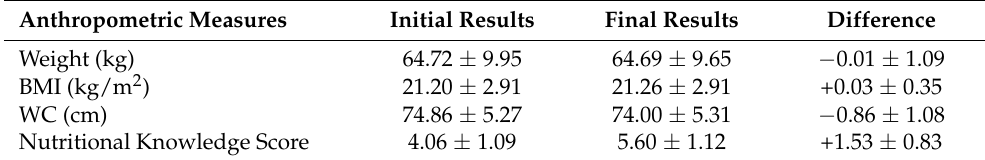
Table 5. Comparison of the anthropometric measurements and scores obtained in the assessment of nutritional knowledge before and after the intervention